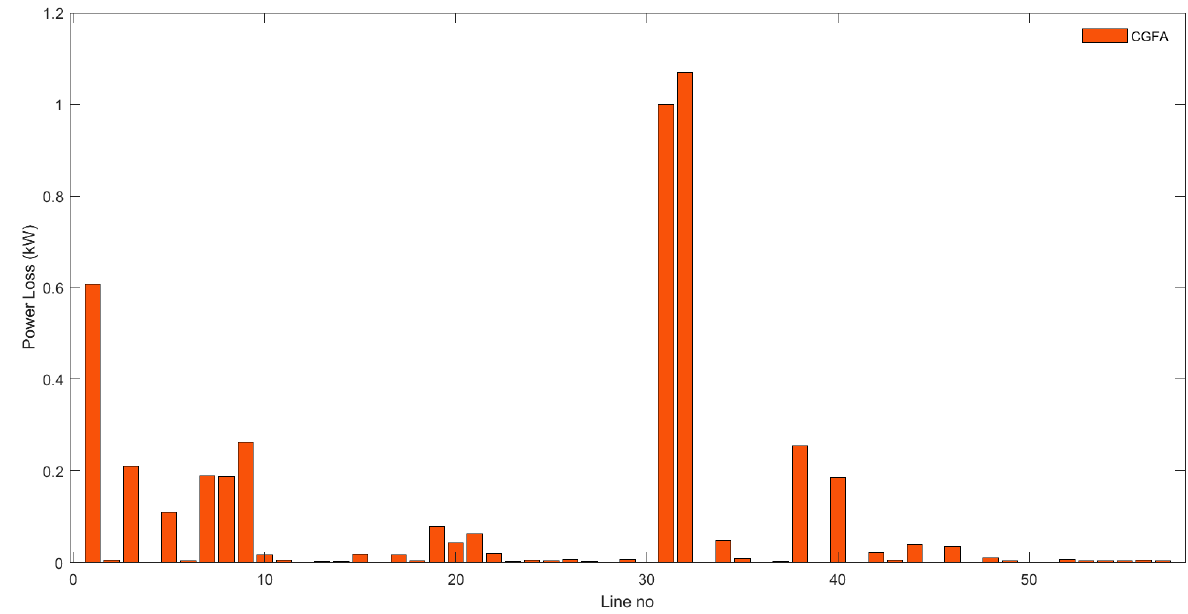
Figure 15. Individual power losses on all lines of an Indian 52-bus system.